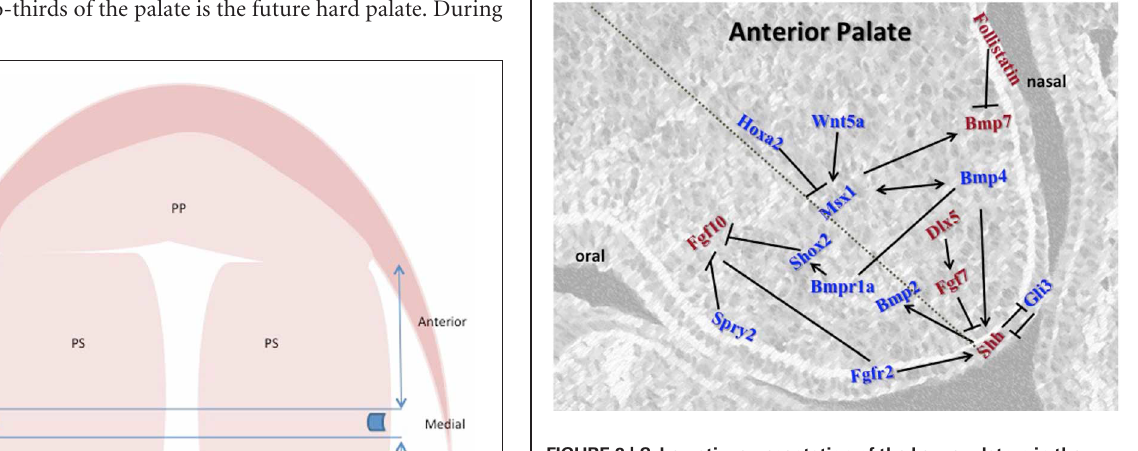
FIGURE 2 | Schematic representation of the key regulators in the anterior palate. Msx1 and Bmp4 function in an autoregulatory loop mechanism in the mesenchyme. Bmp4 induces Shh expression in the epithelium which signals backs to the mesenchyme to positively regulate Bmp2 to enhance cell proliferation in the mesenchyme. Msx1 expression is controlled by Hoxa2 in early palatal development. Fgfs and their receptors are regulated by Spry 2 for proper balance of proliferation and prevention of premature apoptosis in the epithelium. Fgf10 induces Shh whereas Fgf 7 acts as an antagonist. Msx1 also maintains proliferation by inducing Bmp 7 in the mesenchyme along the nasal epithelium. Genes represented in red are restricted to either oral or nasal side of the palate, whereas those represented in blue are present across the